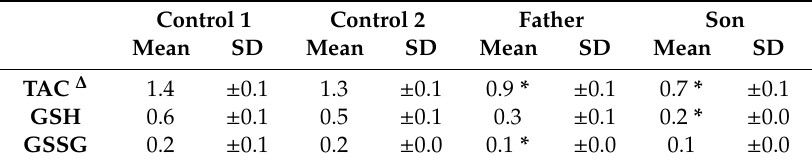
Table 2. Semen redox